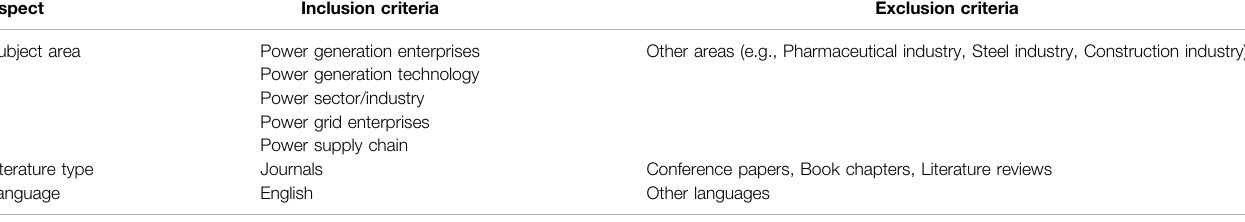
TABLE 1 | Inclusion and exclusion criteria of the literature.